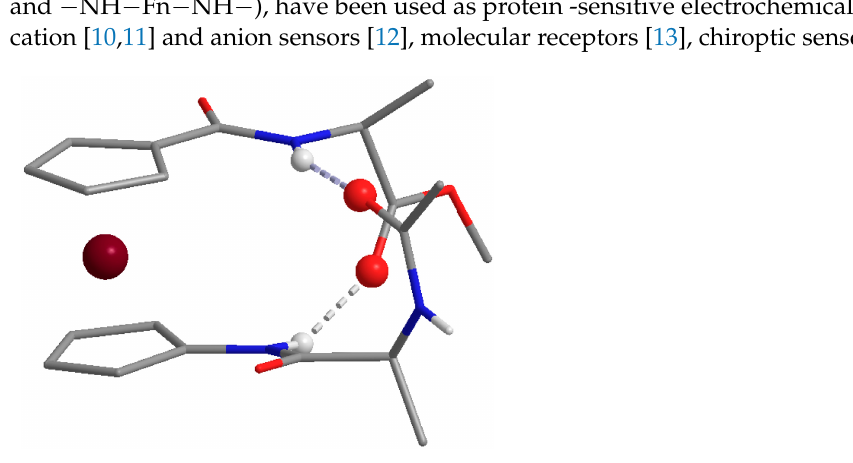
Figure 1. Turn structure in peptidomimetic Ac-Ala-Fca-Ala-OMe (non-polar hydrogens omitted for clarity) [4].